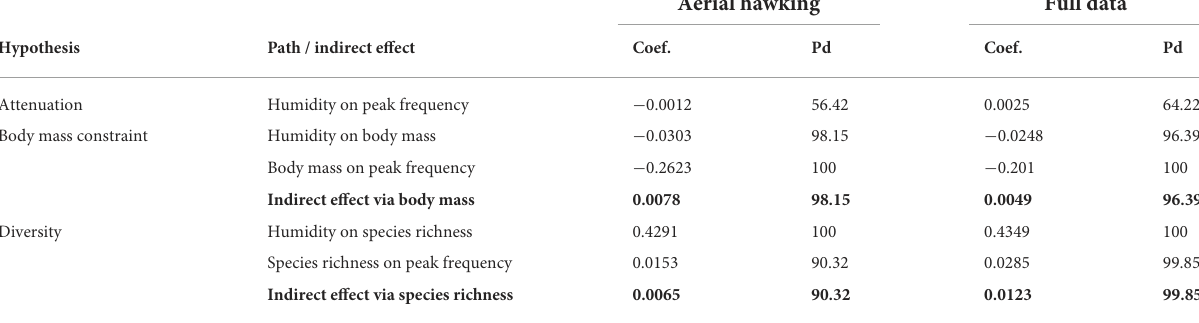
TABLE 2 Path coefficients (coef.) and probabilities of direction (Pd) for each individual path and the corresponding indirect effects (bolded) by dataset: all parameters are calculated from the full posterior distributions with 2,000,000 samples